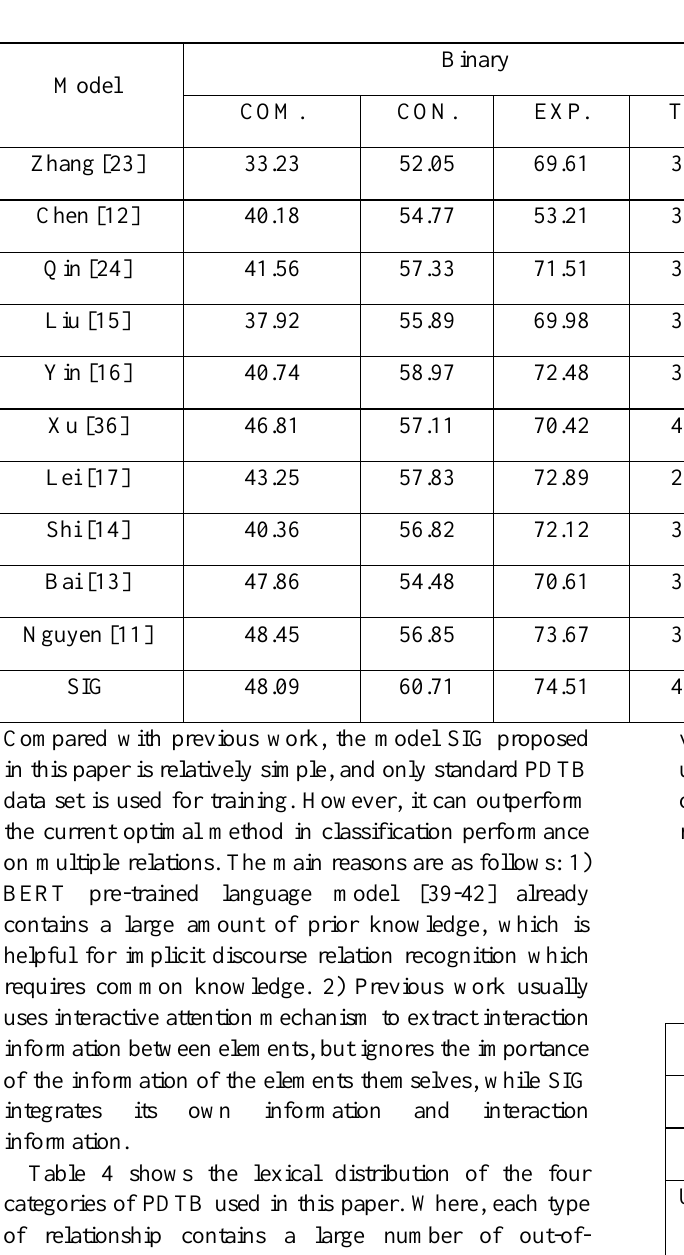
Table 3. Comparison results of SIG and existing advanced models/%